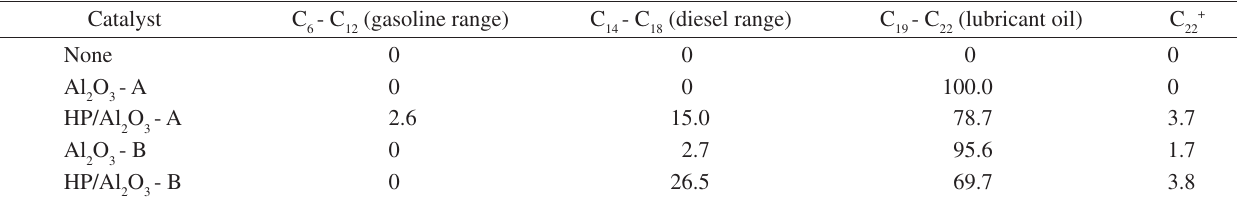
Table 4. Distribution of liquid products expressed in hydrocarbon ranges (weight %).